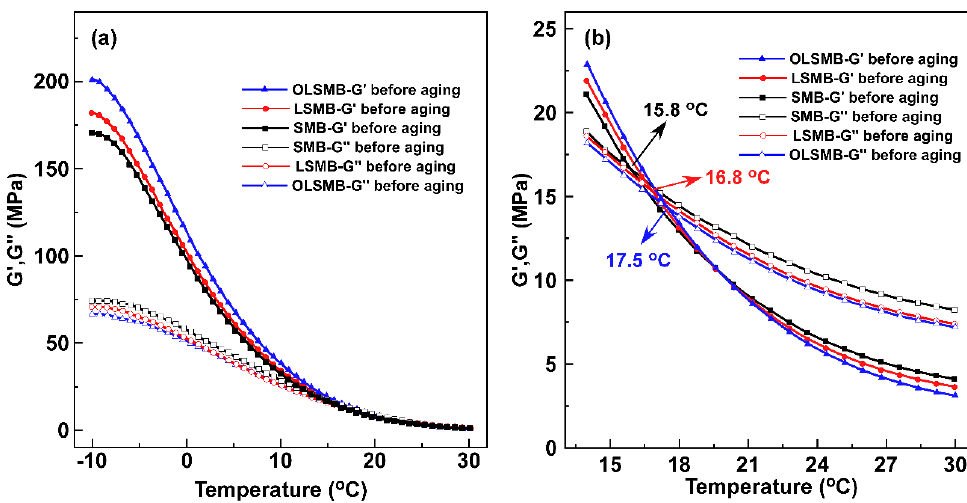
Figure 4. G ′ and G ″ vs. temperature from ( a ) − 10 to 30 °C and ( b ) 14 to 30 °C and the cross points Figure 4. G (cid:48) and G (cid:48)(cid:48) vs. temperature from ( a ) − 10 to 30 ◦ C and ( b ) 14 to 30 ◦ C and the cross points for SMB, LSMB and OLSMB before aging. for SMB, LSMB and OLSMB before